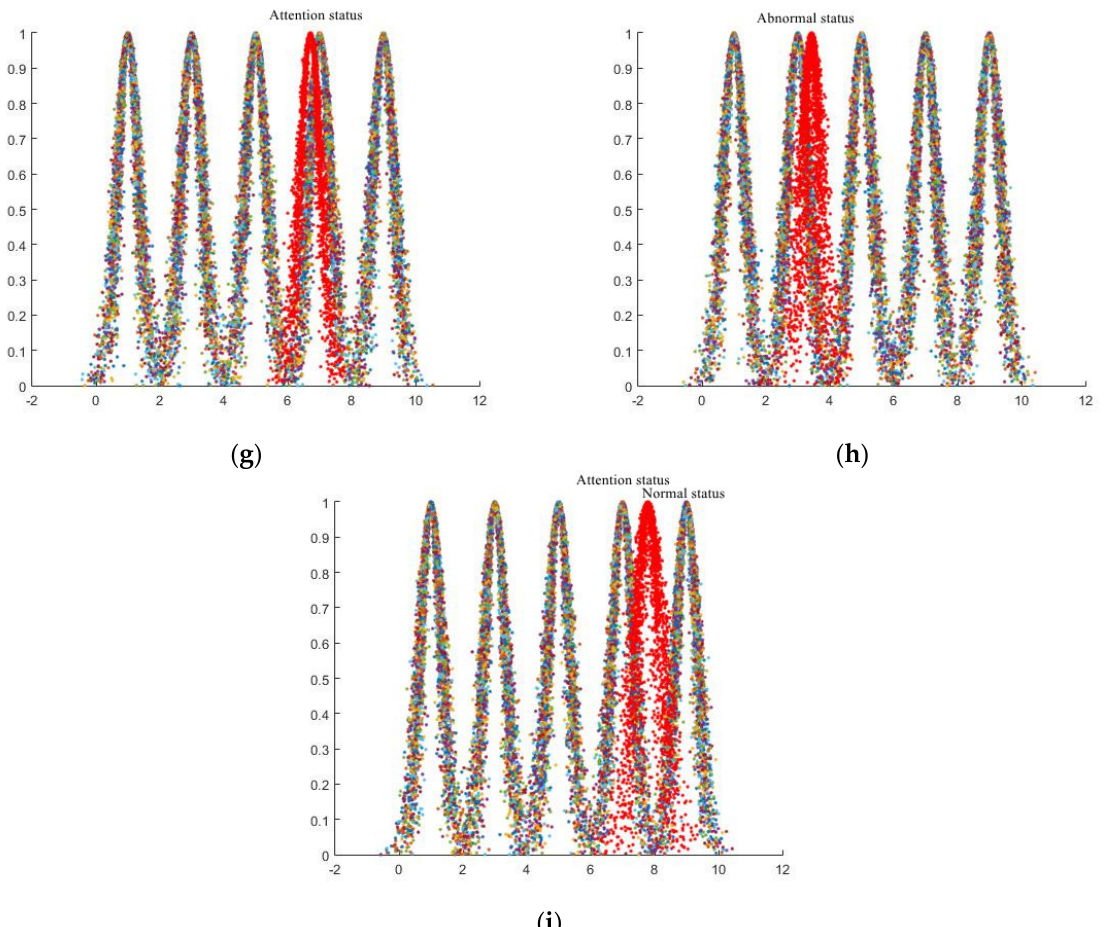
Figure 6. Multiple main objectives affecting the line status are evaluated through the cloud computing platform’s standard-layer dynamic indicators. ( a ) Grounding fittings. ( b ) Auxiliary facilities. ( c ) Towers. ( d ) Foundation. ( e ) Grounding devices. ( f ) Auxiliary facilities. ( g ) Insulator strings. ( h ) Meteorological environment. ( i ) Channel environment.